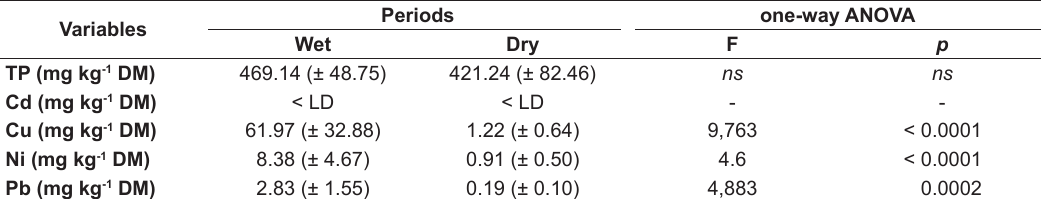
Table 2. Mean values and standard deviation (n = 6) of total phosphorus and metal concentrations in the sediment samples of Garças Reservoir during the wet and dry periods. Results are expressed in dry mass (DM). Limit of detection (LD) to Cd was 0.03 mg L -1 . ns = no significant